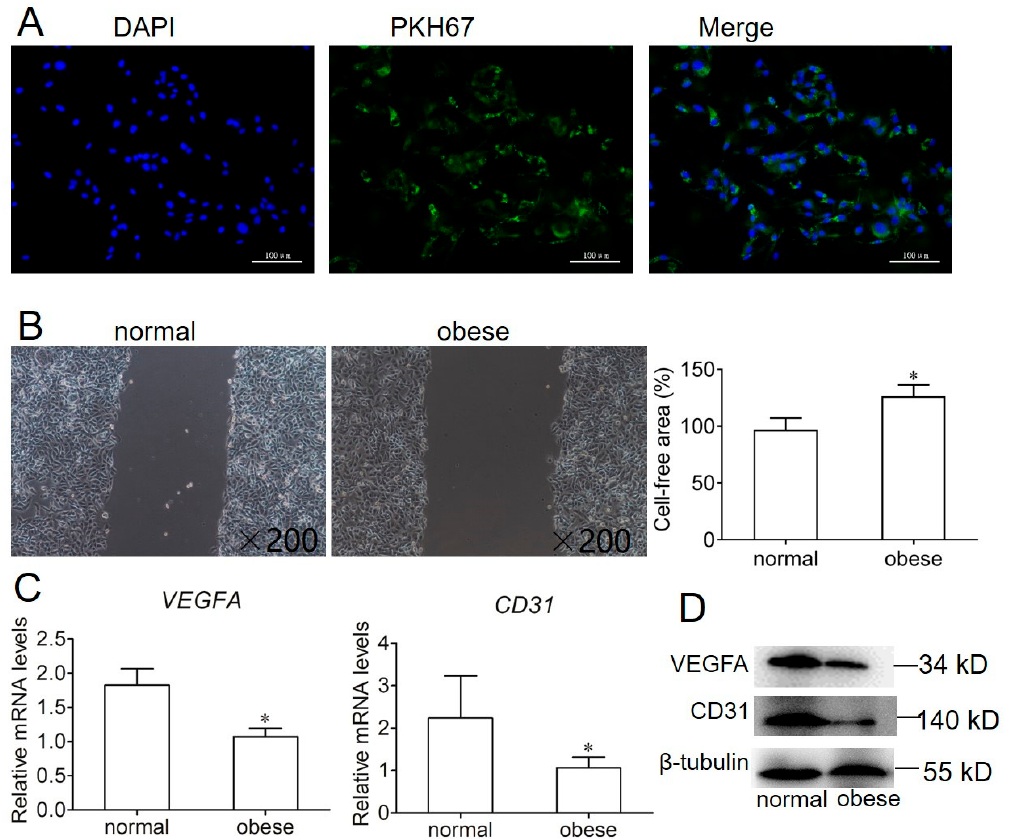
Figure 3. Inhibition of migration and VEGFA and CD31 levels in endothelial cells by obese-derived exosomes. ( A ) Fluorescence images of PKH67-labeled exosomes from sow were internalized into endothelial cells. ( B ) Endothelial cells were scratched and incubated with exosomes from normal or obese sows. ( C ) qPCR was performed to detect the mRNA expression of angiogenic genes VEGFA and CD31 in the two groups. ( D ) Western blotting was conducted to detect the protein expression of VEGFA and CD31 in the two groups. Values are means ± SD. Values are means ± SD (n = 6). * p < 0.05.